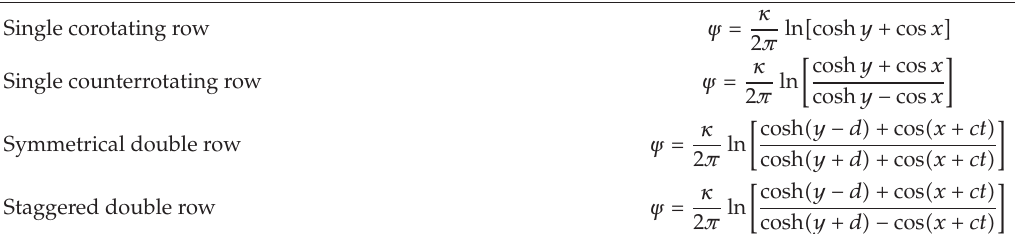
Figure 1: Point vortices on the plane: (cid:5) a (cid:6) a row of corotating vortices; (cid:5) b (cid:6) a row of counterrotating vortices. Table 1: Some two-dimensional vortex